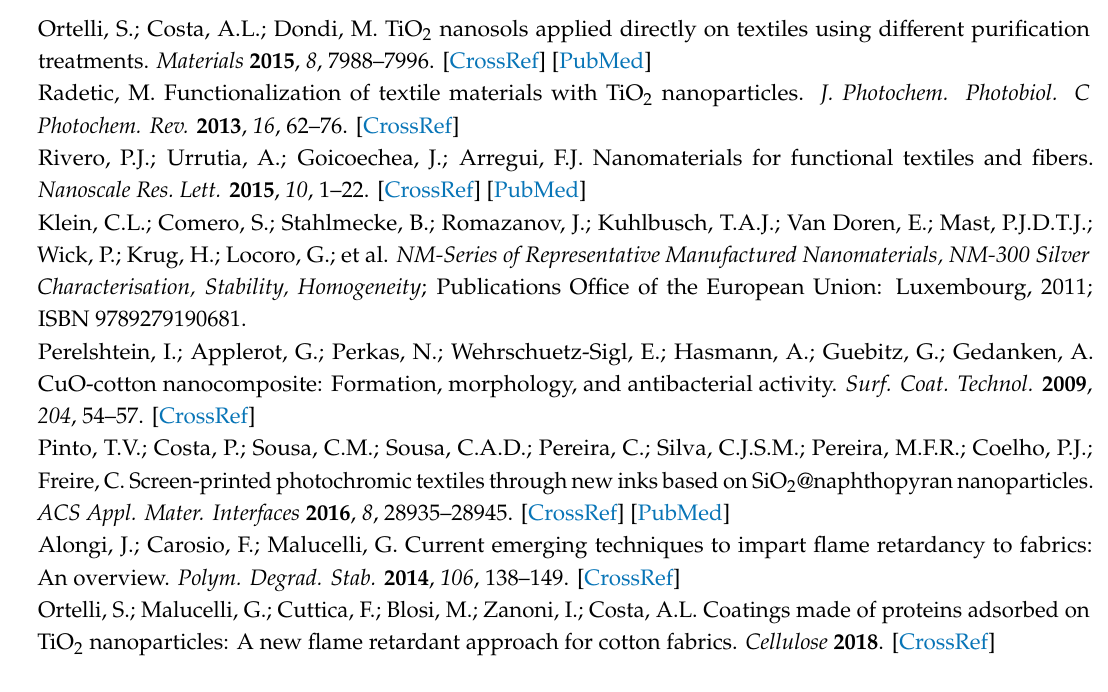
Figure S1: 1 H NMR of [F 2 IrPTZ-Me] + , CD 3 CN, 400 MHz; Figure S2: 1 H NMR of [IrQTZ-Me] + , CD 3 CN, 400 MHz; Figure S3: 13 C NMR of [F 2 IrPTZ-Me] + , CD 3 CN, 400 MHz; Figure S4: 13 C NMR of [IrQTZ-Me] + , CD 3 CN, 400 MHz; Figure S5: ESI-MS spectrum of [IrQTZ-Me] + (positive ions region) [M] + = 712 m / z , CH 3 CN; Figure S6: ESI-MS spectrum of [F 2 IrPTZ-Me] + (positive ions region) [M] + = 734 m / z , CH 3 CN; Figure S7: Comparison between normalised emission profiles [F 2 IrPTZ-Me] + (blue line) and [IrQTZ-Me] + (red line) complexes and their Ir@SiO 2 systems (black lines); Figure S8: EDX spectrum of blue Ir@SiO 2 coated textile; Figure S9: Comparison between normalised emission profile of red Ir@SiO 2 nanosol system (black) and once used as coating on cotton textile (red); Figure S10: Qualitative evaluation of 2p-fluorescen images made by ImageJ on untreated cotton textiles and samples of cotton textile coated by silica, blue Ir@SiO 2 system and red Ir@SiO 2 system; Figure S11: Release tests results collected both in dynamic (left) and static condition (right) for textiles coated by three-layer of blue Ir@SiO 2 system; Figure S12: EDX spectrum of blue Ir@SiO 2 coated textile; Figure S13: Real image of fabric samples under UV lamp ( λ em = 365 nm): silica coated (A), blue Ir@SiO 2 coated after 10 days of washing test in static condition (B), blue Ir@SiO 2 coated after 2 years (C) and red Ir@SiO 2 coated after 2 years (D) cotton textiles; Figure S14: Image of AATCC 147 tests on red Ir@SiO 2 coated textiles once exposed in dark (I), natural light (II) and natural light + UV (III) conditions; Table S1: Spectrometric relevant data, expressed as absorption and emission, of cationic Ir(III) complexes and Ir@SiO 2 nanosols systems; Table S2: SiO 2 weight loss% data relative to release test in dynamic condition (test for three layers coated textiles); Table S3: Cumulative SiO 2 weight loss% data relative to release test in static condition for blue Ir@SiO 2 coating (test for three layers coated